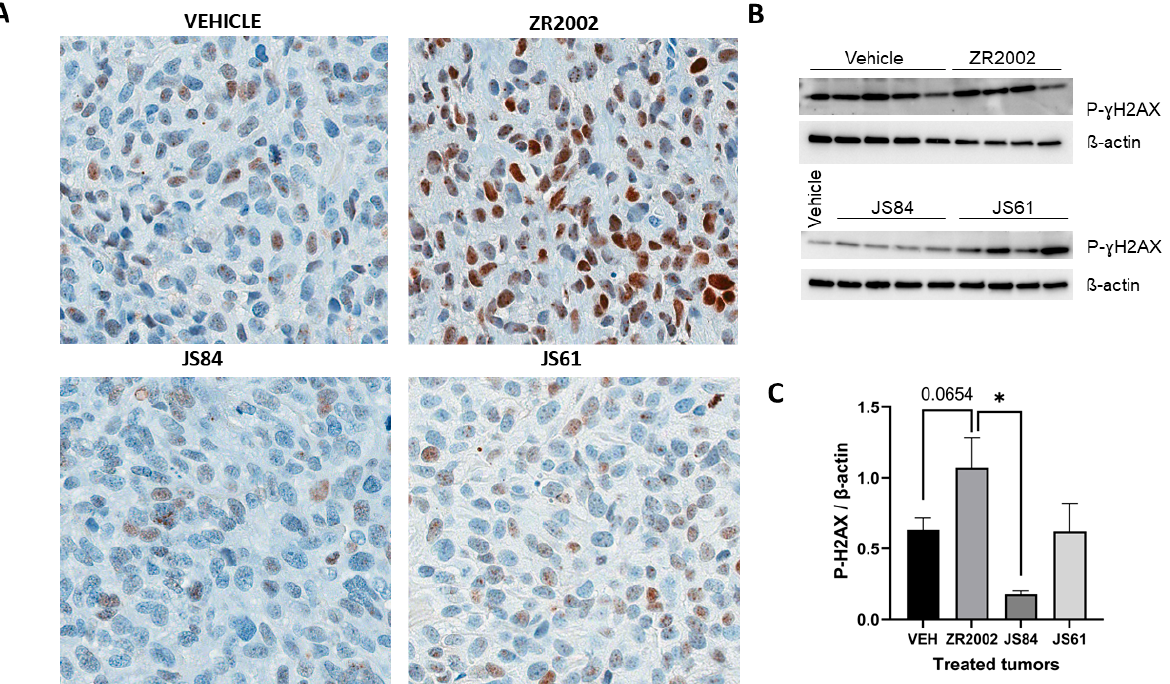
Figure 5. Immunohistochemistry and Western blot analysis of the effects of ZR2002, JS84 and JS61 on tumor tissues. ZR2002 increases the phosphorylation of ɣ -H2AX (P- ɣ H2AX). ( A ) Representative tumor sections of Saos-2 tumors stained for P- ɣ H2AX. ( B ) Western blots for P- ɣ H2AX and β -actin, which was used as internal control. ( C ) Quantification of Western blots: ratio of band intensity between P- γ H2AX and β -actin. Data are expressed as means ± SEM. * p < 0.05 between the two groups.